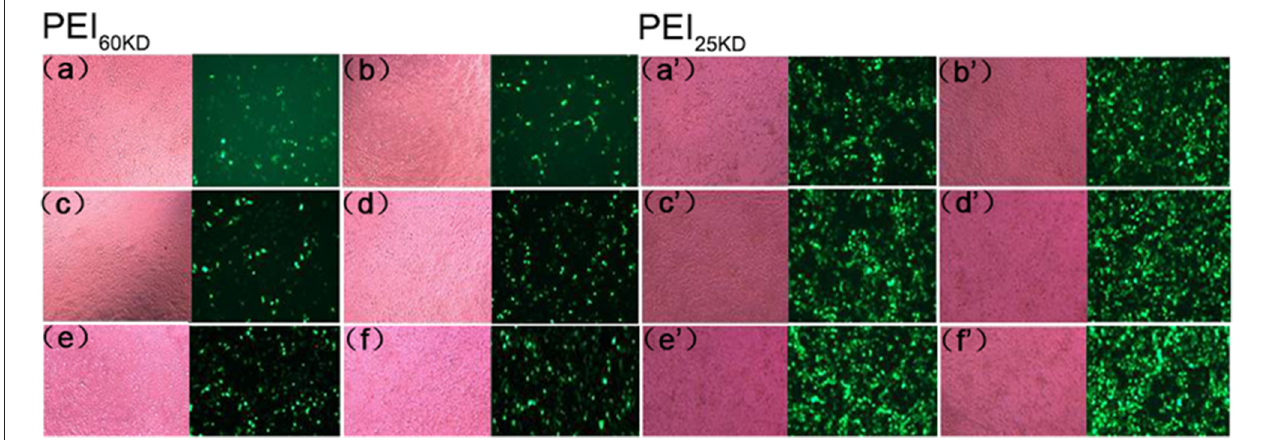
FIGURE 4 | Optical (left) and fluorescent (right) images of HEK293T cells transfected with plasmid EGFP using (a–f) PEI 60kD at N/P = 80 and (a’–f’) PEI 25kD at N/P = 160, at a post transfection time of 48h. EV solution of different volume (0, 0.5, 1, 2, 5, and 10 µ L) were added into each well of the 96-well plate for images (a–f) and for (a’–f’) , respectively. The protein concentration in EV solution was 3 ng/ µ L − 1 All the images were taken at the same exposure time